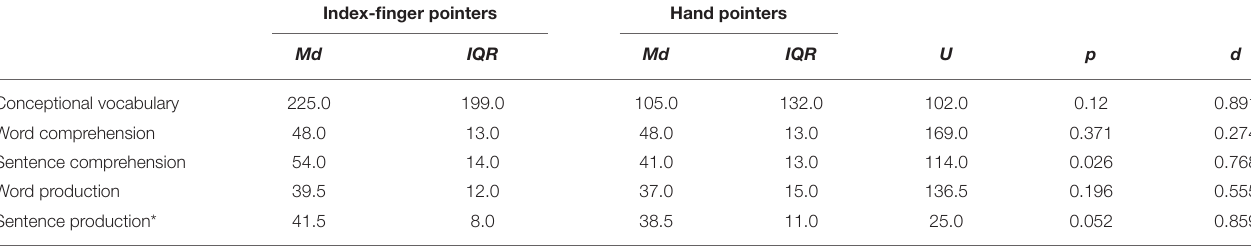
TABLE 2 | Comparison of language skills at 24 months between index-finger pointers and hand pointers.